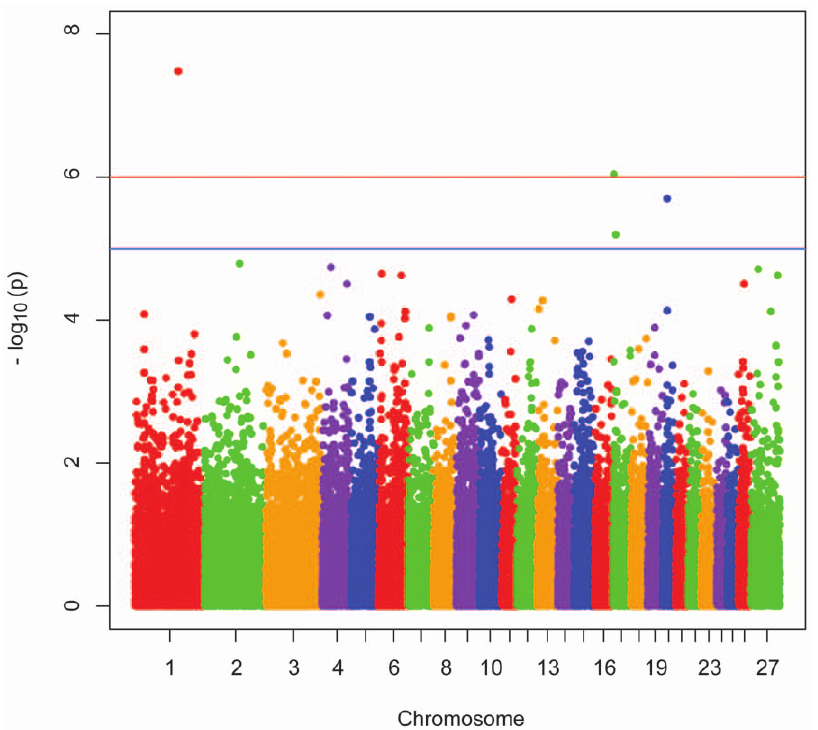
Figure 1. Manhattan plot for susceptibility to OvLV. The Manhattan plot shows nominal P-values from association with serological status by chromosomal position. Representative data from the all-breeds, additive mode of inheritance analysis are shown. The top red line shows a genome- wide significance threshold defined by nominal P-values of 1x10 -6 , which is P=0.05/50,000. The lower blue line shows a genome-wide suggestive significance threshold defined by 1x10 -5 .